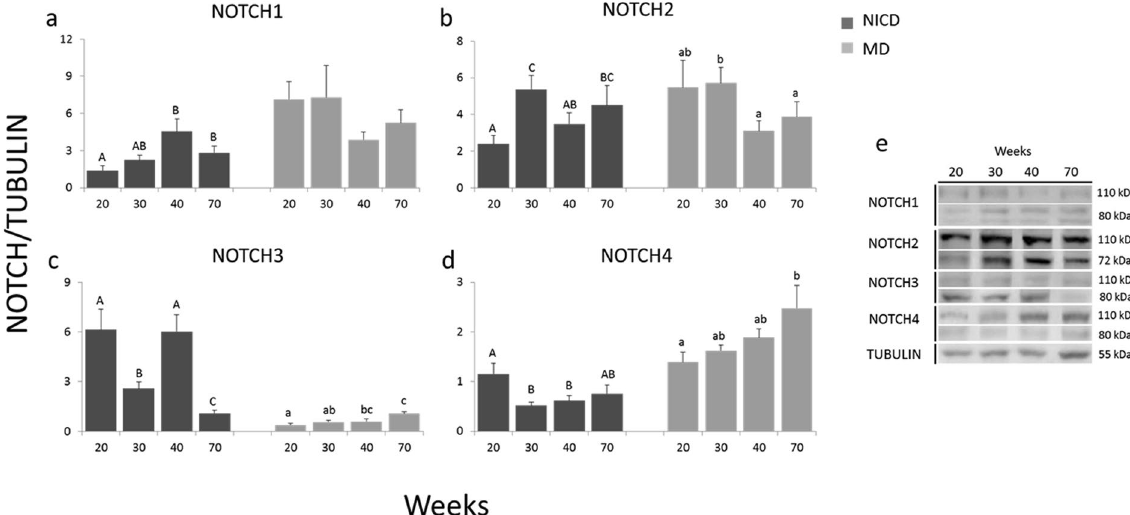
Figure 2. Intracellular (NICD, black bars) and membrane (MD, grey bars) domains of NOTCH1–4 were determined by Western blot in mammary glands of heifers aged 20, 30, 40 and 70 weeks, and were expressed in relation to tubulin expression (n = 6, 10, 10, 10 (a) ); (n = 7, 10, 10, 9 (b) ); (n = 10, 10, 10, 7 (c) ); (n = 7, 7, 7, 6 (d) ). For this and the following figures, lines on the top of the bars represent 1 SE. Different capital letters mean statistical differences (P < 0.05) between ages for NICD, and lower case letters for MD. Representative Western blots showing the active NICD (80 or 72 kDa) and membrane domains (110 kDa) of NOTCH 1–4 receptors in the four ages studied are shown (e) . Full-lenght blots are shown in Supplementary Fig.